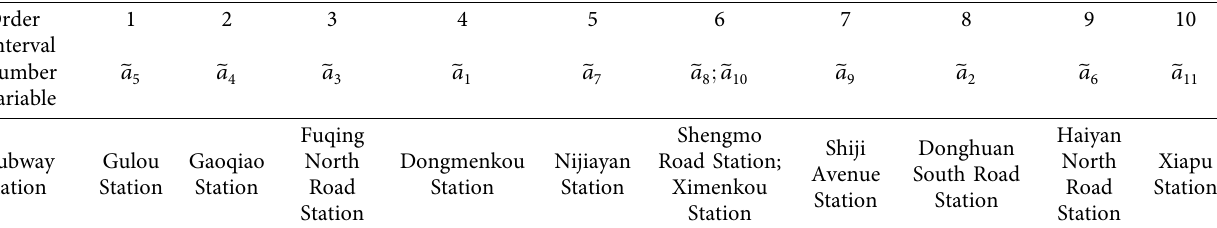
Table 4: Ranking result of transfer